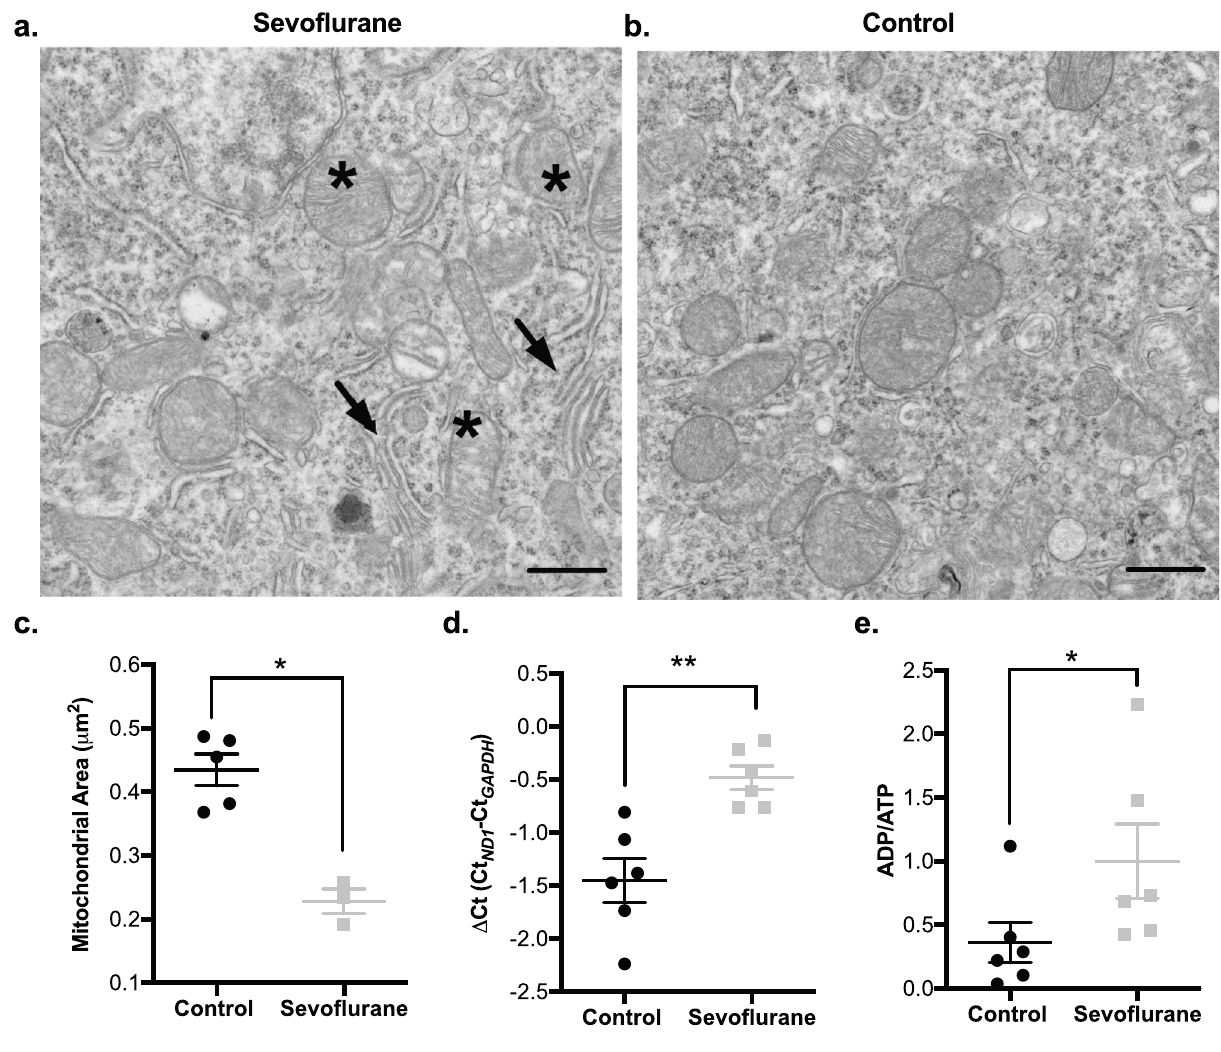
Figure 1. Infant (P7) sevoflurane exposure alters mitochondrial ultrastructure and energetic status in adult rat cortical tissue. Transmission electron microscopy (TEM) imaging illustrates significant changes to mitochondrial ultrastructure including swollen cristae (*), dilated rough endoplasmic reticulum (arrows) and a decreased average mitochondrial size (increase in fragmented phenotype) with infant sevoflurane exposure. ( a ) representative P7 sevoflurane-exposed adult rat cortical brain TEM image, ( b ) littermate control adult rat cortical brain TEM image. In cortical tissue, sevoflurane treatment resulted in a reduction in ( c ) average mitochondrial size (area, from TEM) and ( d ) relative cortical mitochondrial DNA content (ΔC t comparing mitochondrial ND1 to nuclear GAPDH ). ( e ) Sevoflurane reduces energy availability, illustrated through an increased ADP/ATP. TEM magnification ×20,000, scale bars represent 500 nm. Values represent means ± SEM, with 6 animals in each group. Statistical significance between groups indicated with (*) for p -value < 0.05, and (**) for p- value <